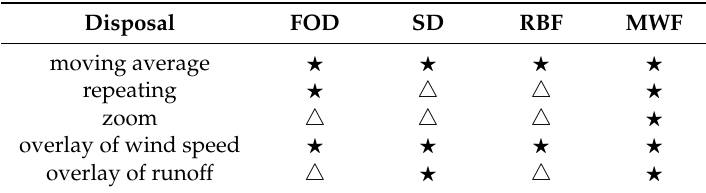
Table 2. Comparison of index performances in various